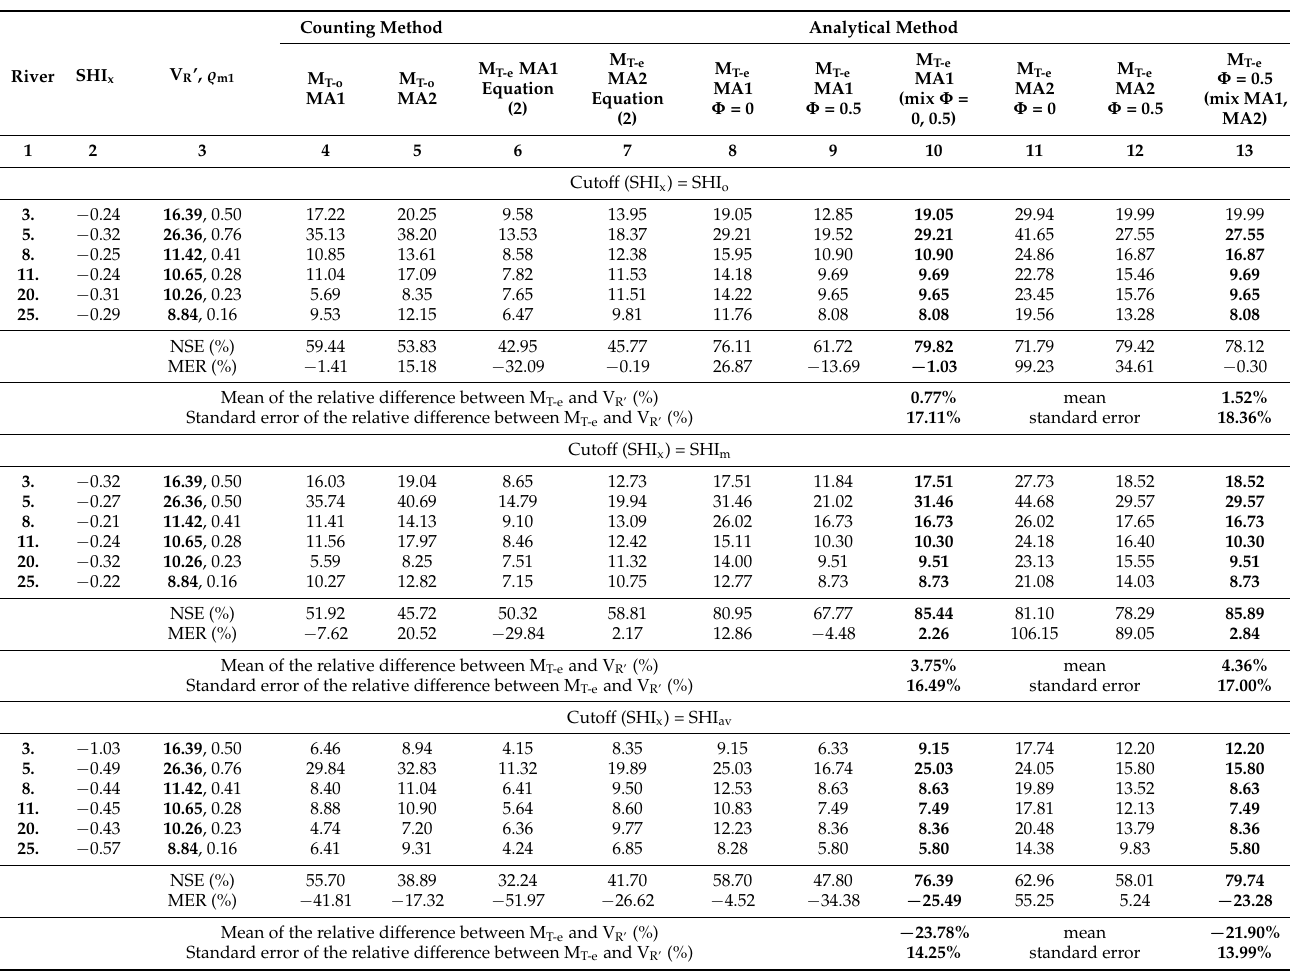
Table 4. Comparison of M T-o and M T-e with V R ’ at the draft level of 0.75 µ a using varying cutoff levels in the SHI sequences: monthly